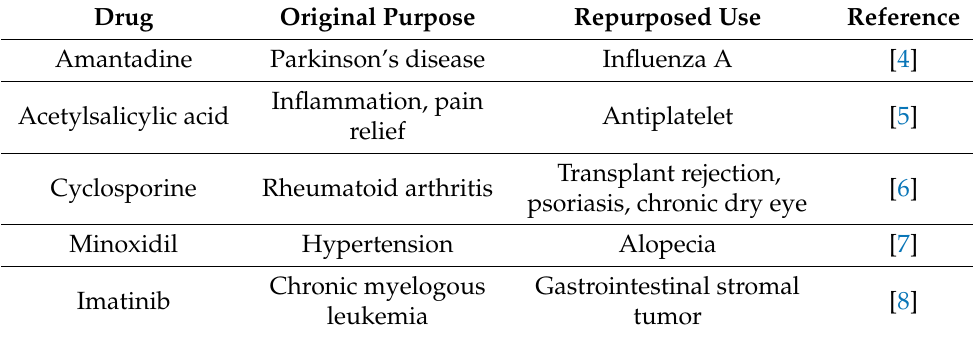
Table 1. Examples of some FDA-approved repurposed